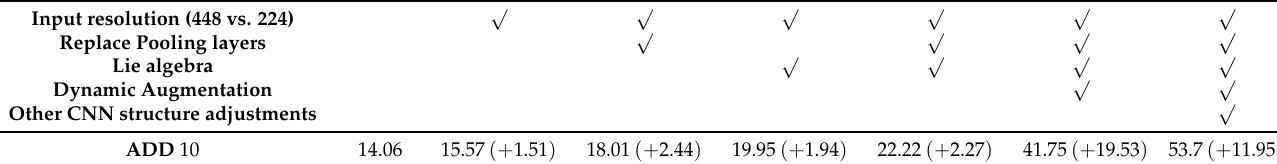
Table 1. We evaluated the proposed contributions in an ablation study. The networks have been tested with the Driller object of the LINEMOD dataset using the Average Distinguishable Distance (ADD) metric with a threshold of 10%. Dynamic augmentation means that the random augmentations will be applied after the images have been loaded for training (as we also mentioned in the end of Section 4.2). The details of other modifications in the table are described in Section 4.1.1. Input resolution (448 vs. 224)